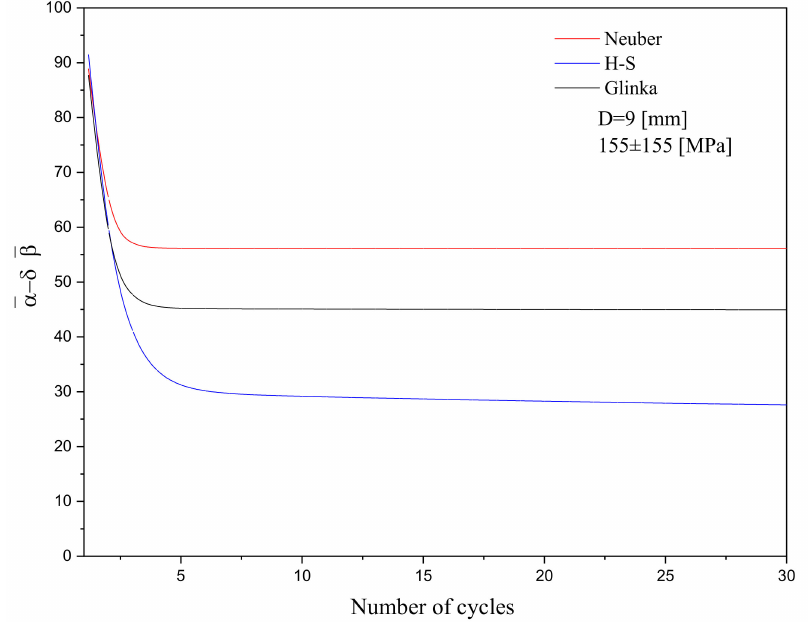
Figure 8. Backstress evolution over the first 30 loading cycles based on the Neuber, H-S, and Glinka rule coupled with the A-V kinematic hardening rule for a steel specimen and an 8 mm diameter under 155 ± 155